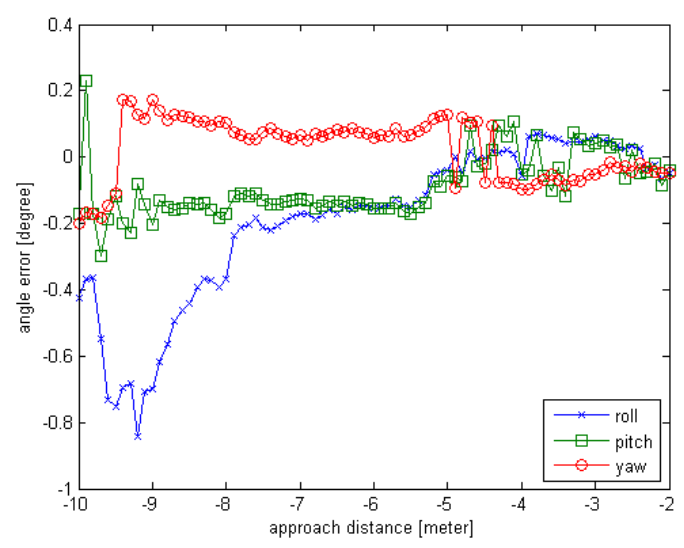
Figure 12. The rotation error curve of Experiment 4 for relative motion.